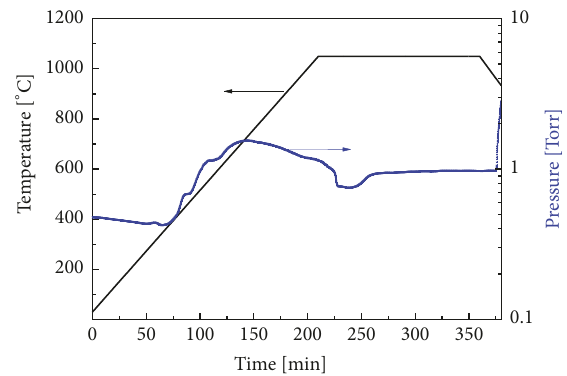
Figure 4: Temperature and pressure profiles as a function of time during salt